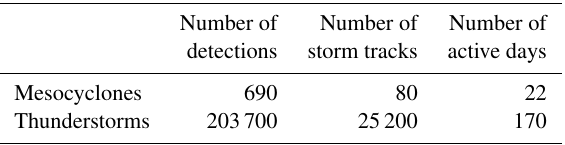
dots indicate the locations of the five radars. With the topog- Table 1. Overall annual average occurrence of mesocyclones and thunderstorms during 2016–2020 in the Swiss weather radar net-